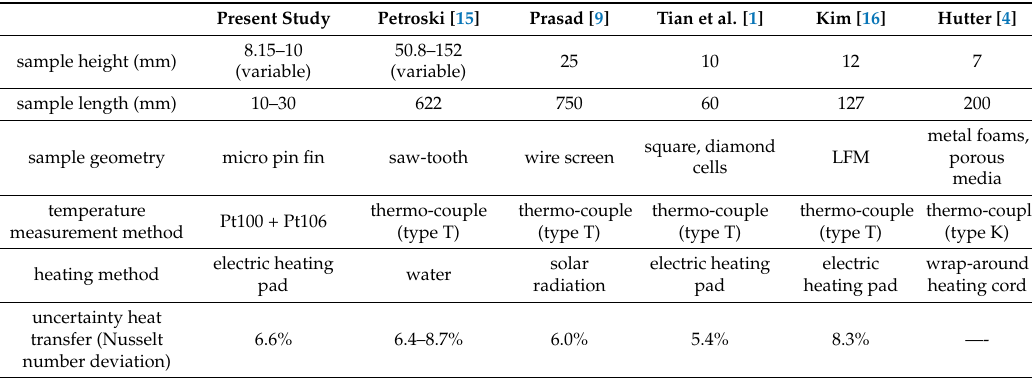
Table 1. Characteristics of test facilities in literature for small scale heat exchanger samples; air as flow